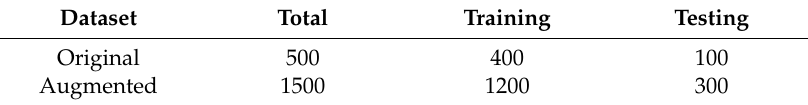
Table 2. The number of training and testing images in original and augmented